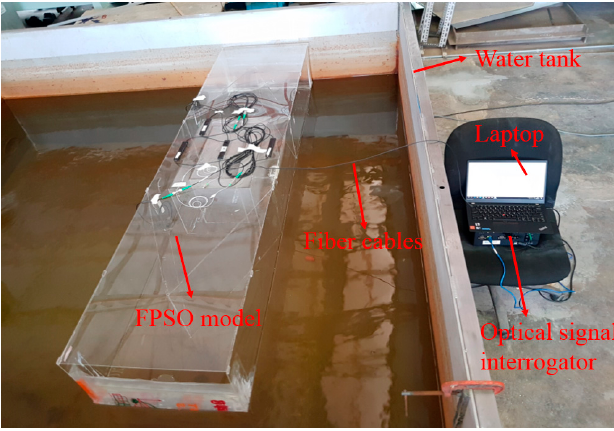
Figure 18. The experimental scene in the laboratory.